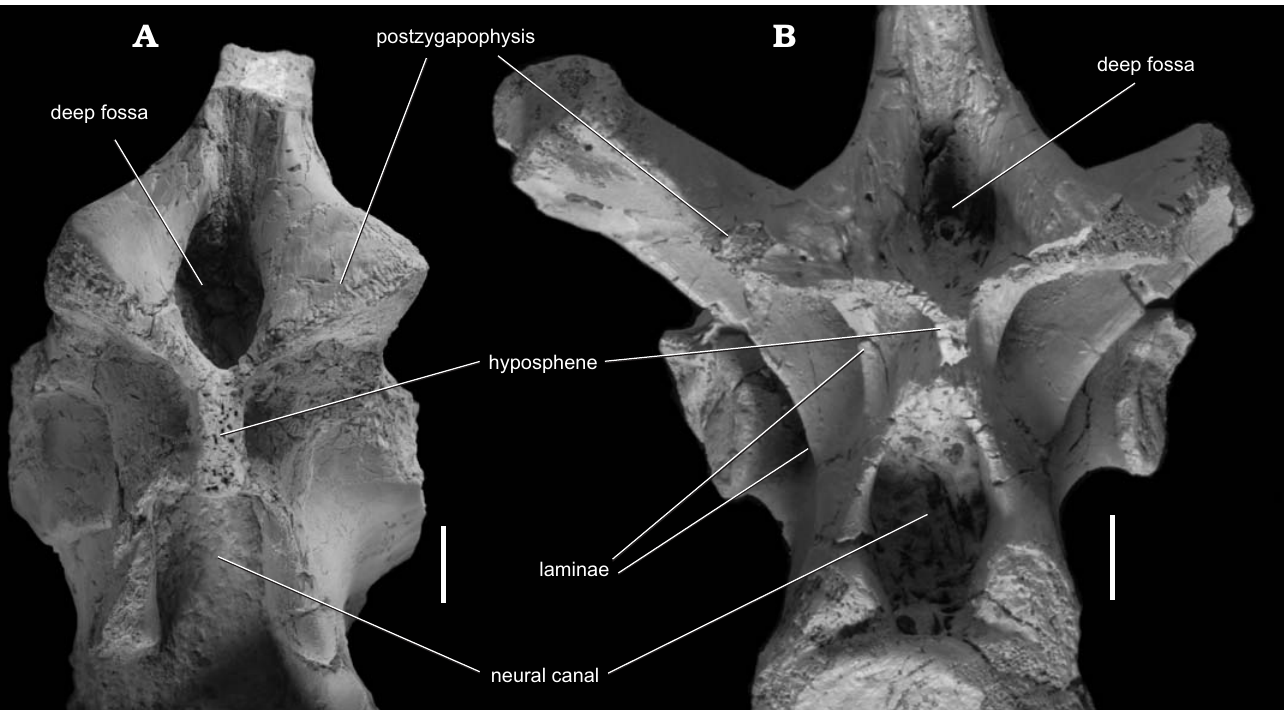
Fig. 5. Comparison and details of articular surface of the mid-dorsal vertebrae (in posterior view) of the predatory archosaurs from Late Triassic of Poland. A . Smok sp. (WNoZ/S/7/199), Marciszów near Zawiercie. B . Smok wawelski Nied ź wiedzki, Sulej, and Dzik, 2012 (ZPAL V.33/42), Lipie Ś l ą skie clay-pit at Lisowice. Scale bars 10